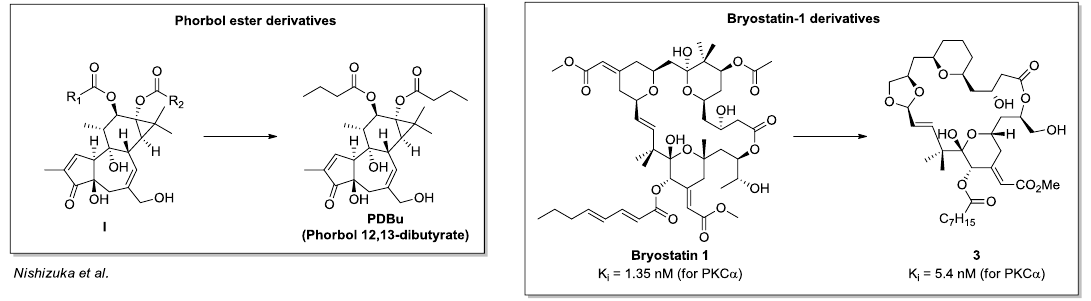
Figure 7. Phorbol ester and bryostatin-1 derivatives.